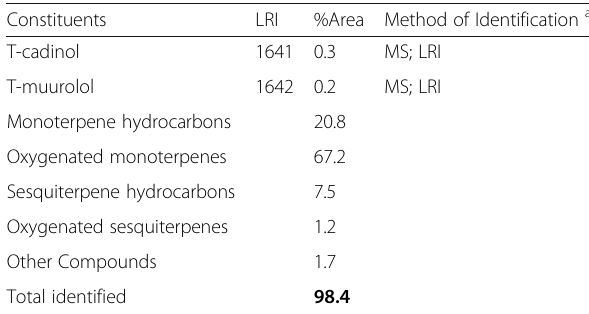
Table 1 Chemical composition of the essential oil from aerial parts of M. spicatai (Continued)